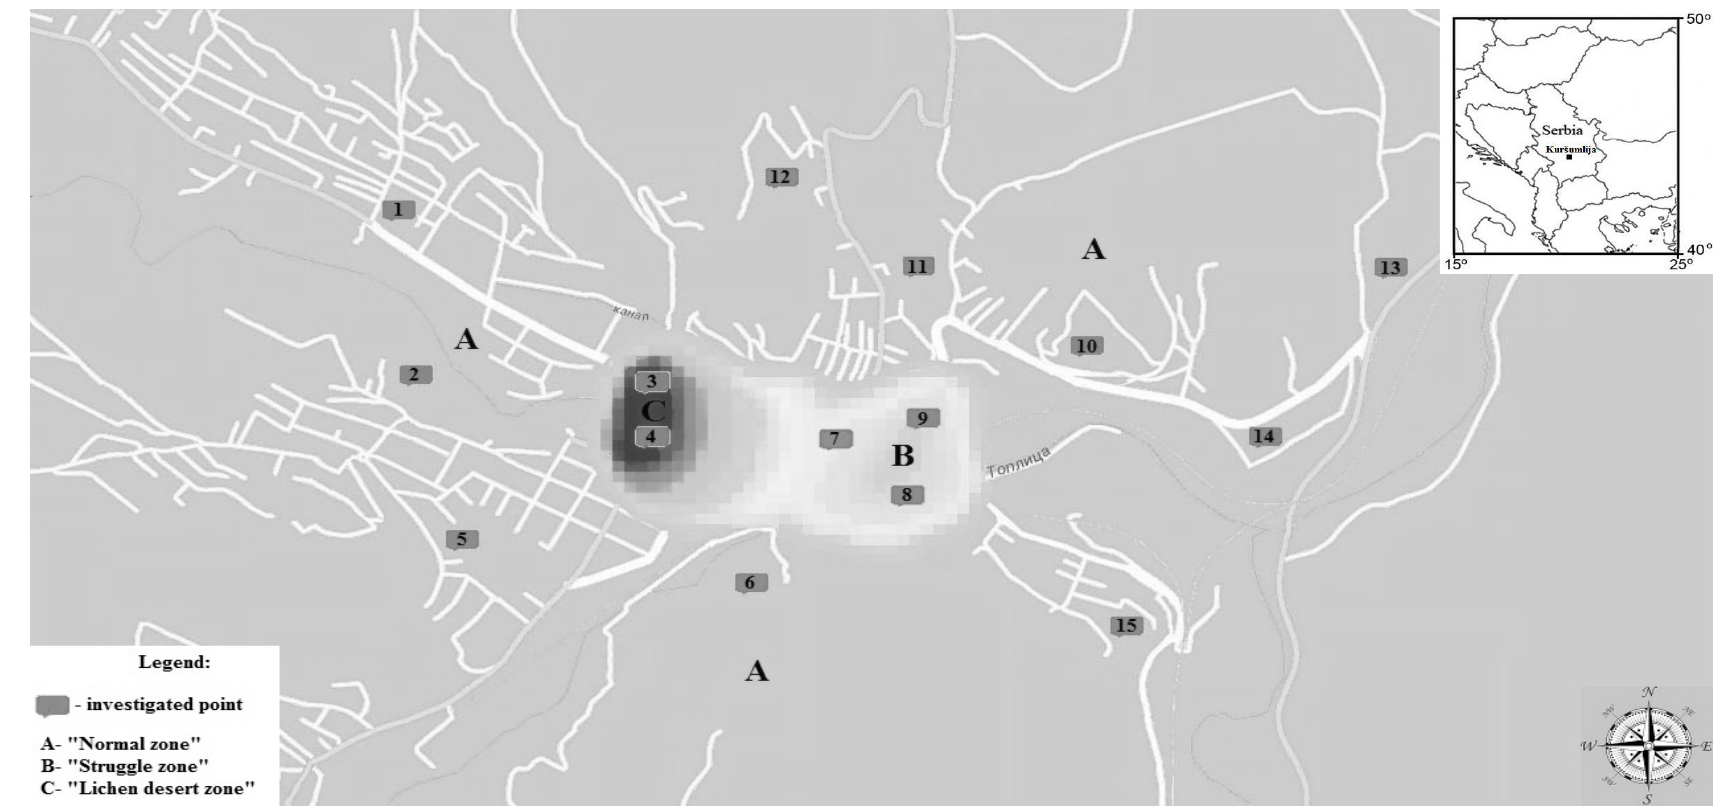
Figure 2. Zones of different levels of air pollution in Kuršumlija defined by using lichens as